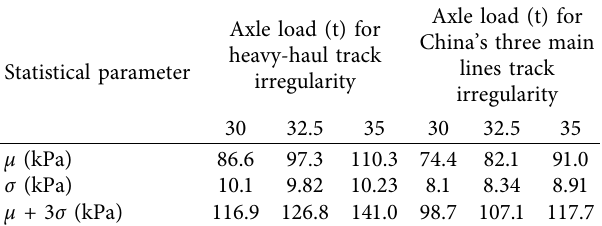
Table 5: Statistical results of the maximum dynamic stress at the subgrade